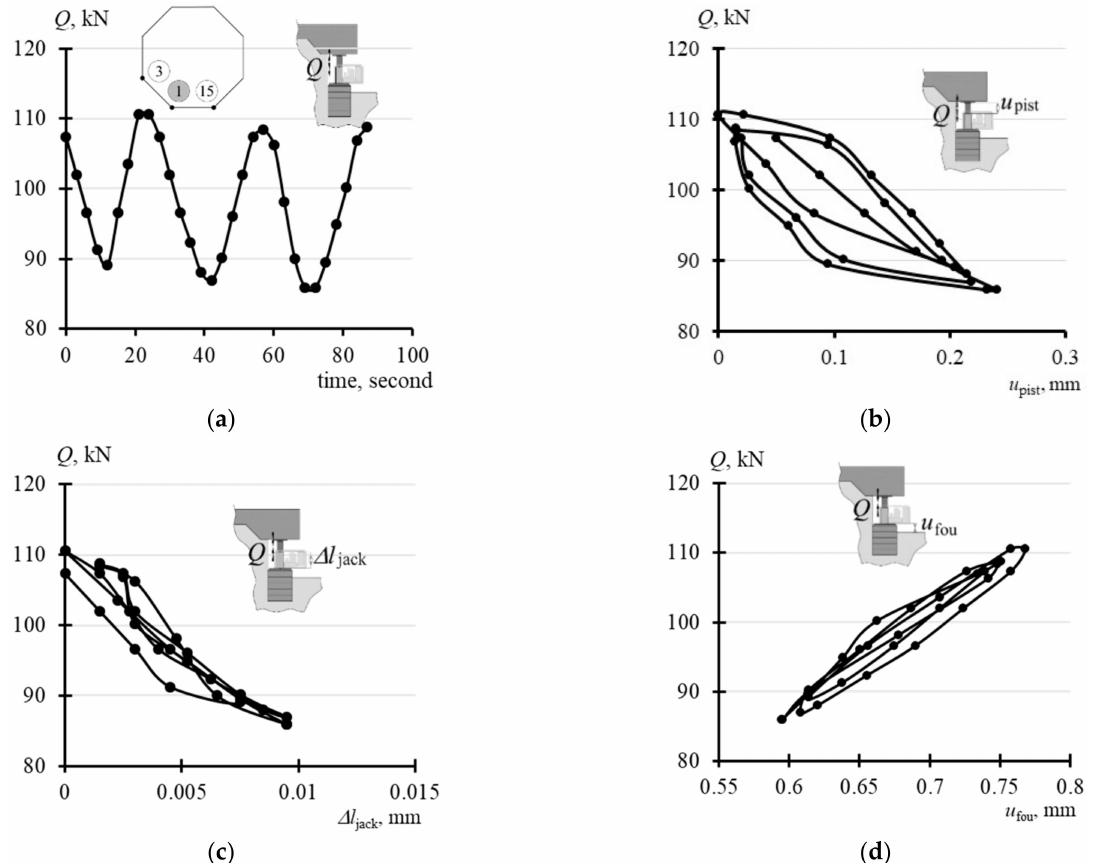
Figure 9. In-situ measurement results at the position of the passive jack: ( a ) Q —time; ( b ) Q — u pist ; ( c ) Q — ∆ l jack ; ( d ) Q — u fou ; 1, 3, 15–jack